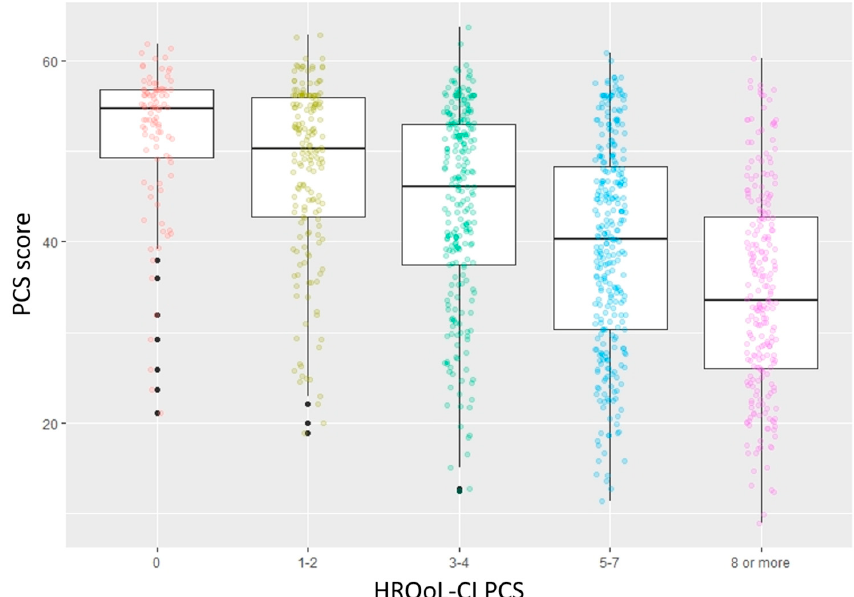
Figure 4. Results for concurrent criterion validity of Mental Component Summary Score in the Short-Form 12-Item Survey—version 2 among an older (65 years or greater) US population (MCS score: Mental Component Summary Score; HRQoL-CI MCS: Health-Related Quality of Life Comorbidity Index (Mental Component Score)).